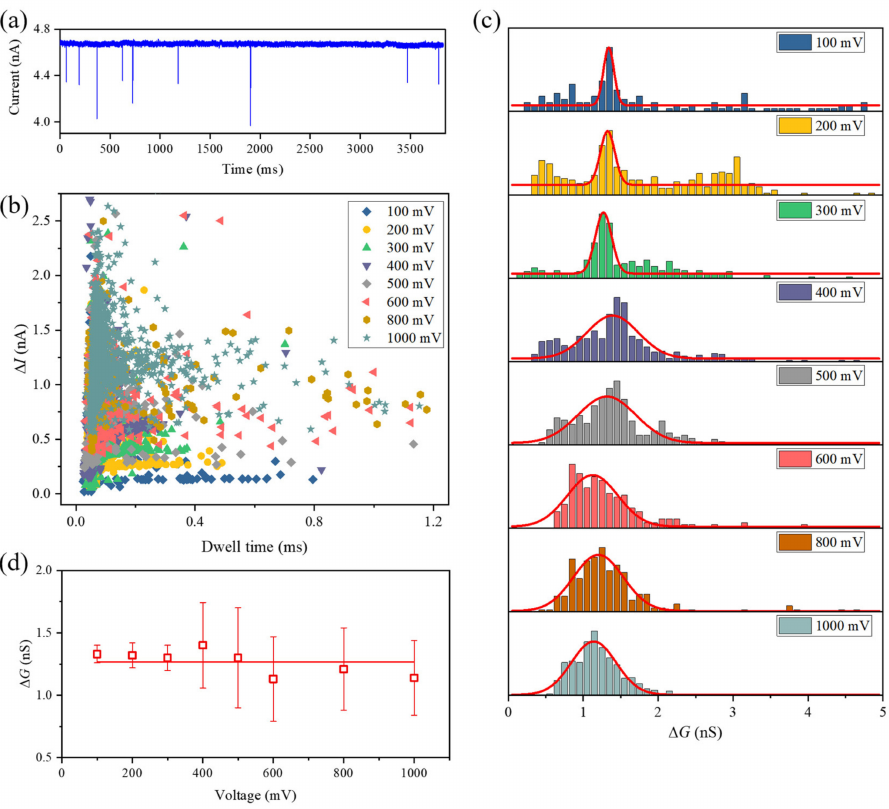
Figure 4. ( a ) Ionic current trace of the translocation of λ -DNA molecules through an 8 nm-diameter nanopore in 1 M KCl with an applied voltage of 200 mV; ( b ) scatter plot of dwell time versus current blockade at various voltages, ranging from 100 to 1000 mV; ( c ) histograms of ∆ G for λ -DNA molecule translocation through the nanopore. Solid red lines represent the fit of a Gaussian distribution to the experimental data, from which we extracted the mean ∆ G ; ( d ) mean ∆ G of translocation events with various